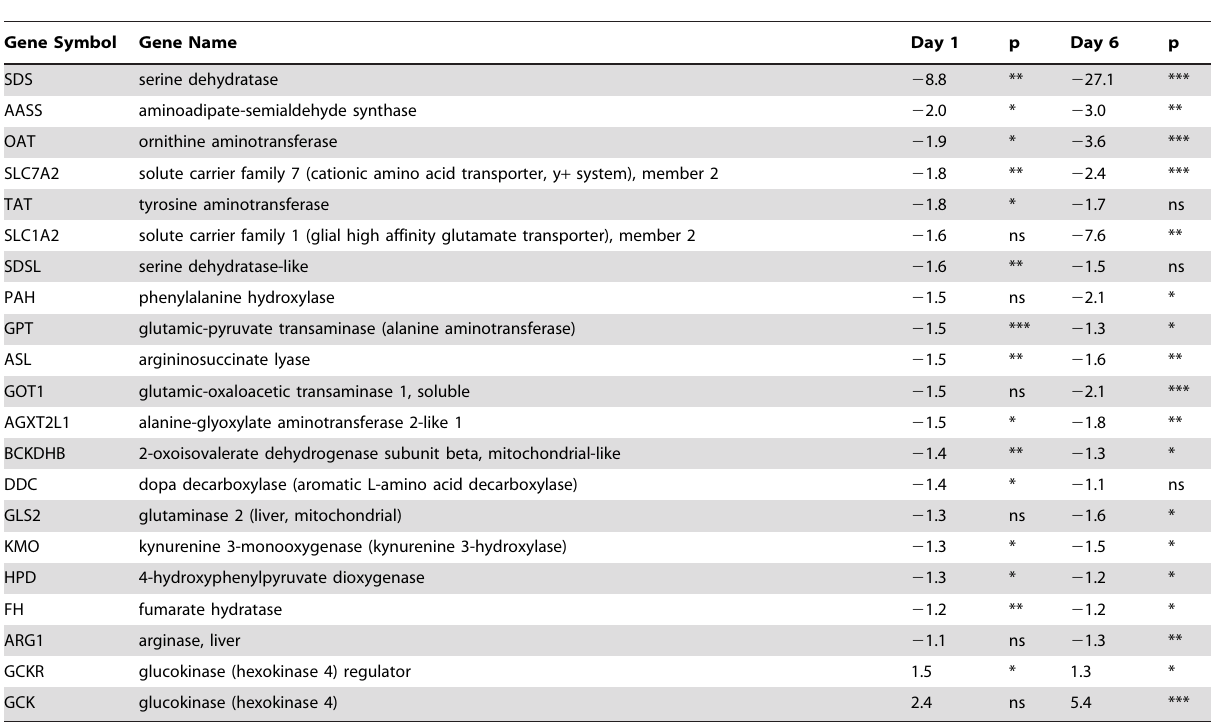
Table 5. Genes involved in amino acid and glucose metabolism that were expressed differentially in rhesus monkey liver depending or whether animals received 30 mg/kg GRA1 or vehicle (yogurt without drug) twice daily for 6 days (n=5 per group).